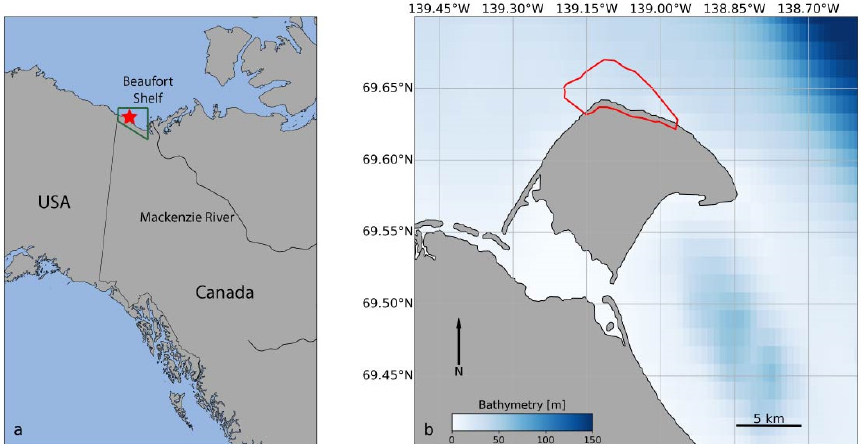
Figure 1. ( a ) Location of the study area close to the northernmost border of Canada and the USA. The green polygon marks the area where ERA5 data were retrieved; ( b ) Herschel Island Qikiqtaruk, located on the Canadian Beaufort Shelf. The area of interest is highlighted in red. Geographic coordinates were retrieved from WGS84 projection.